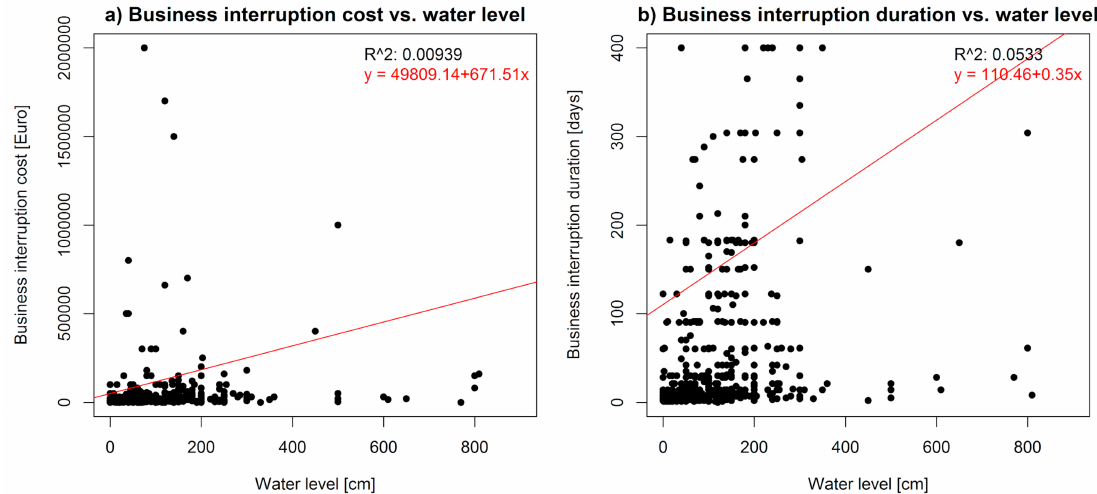
Figure 5. Scatter plots of ( a ) business interruption cost vs. water level and ( b ) business interruption duration vs. water level, separately with a regression